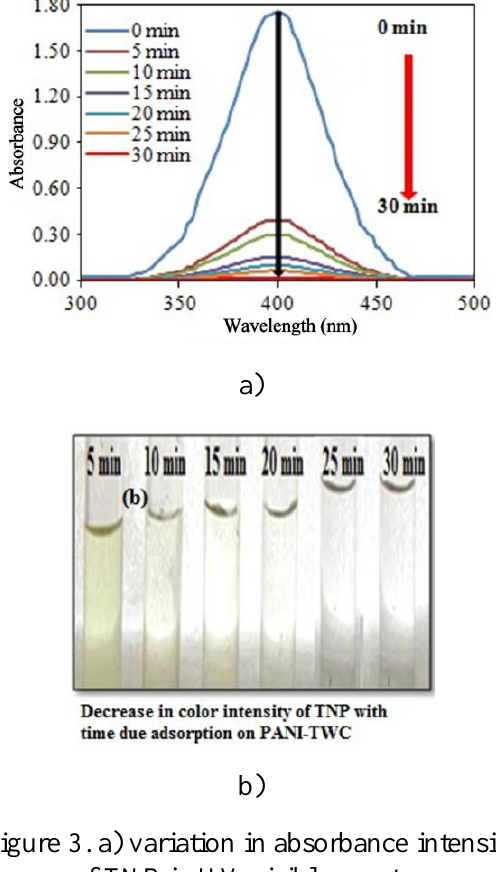
Figure 2. Relation between q